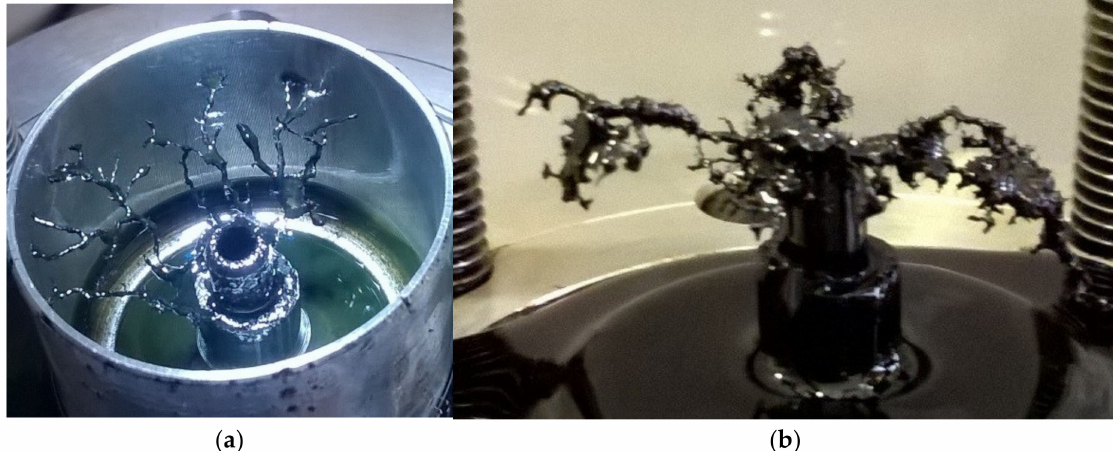
Figure 9. Photographs of tree-like structures formed: in microwave discharge in liquid engine oil ( a ); and in liquid residues of heavy petroleum feedstock ( b ).